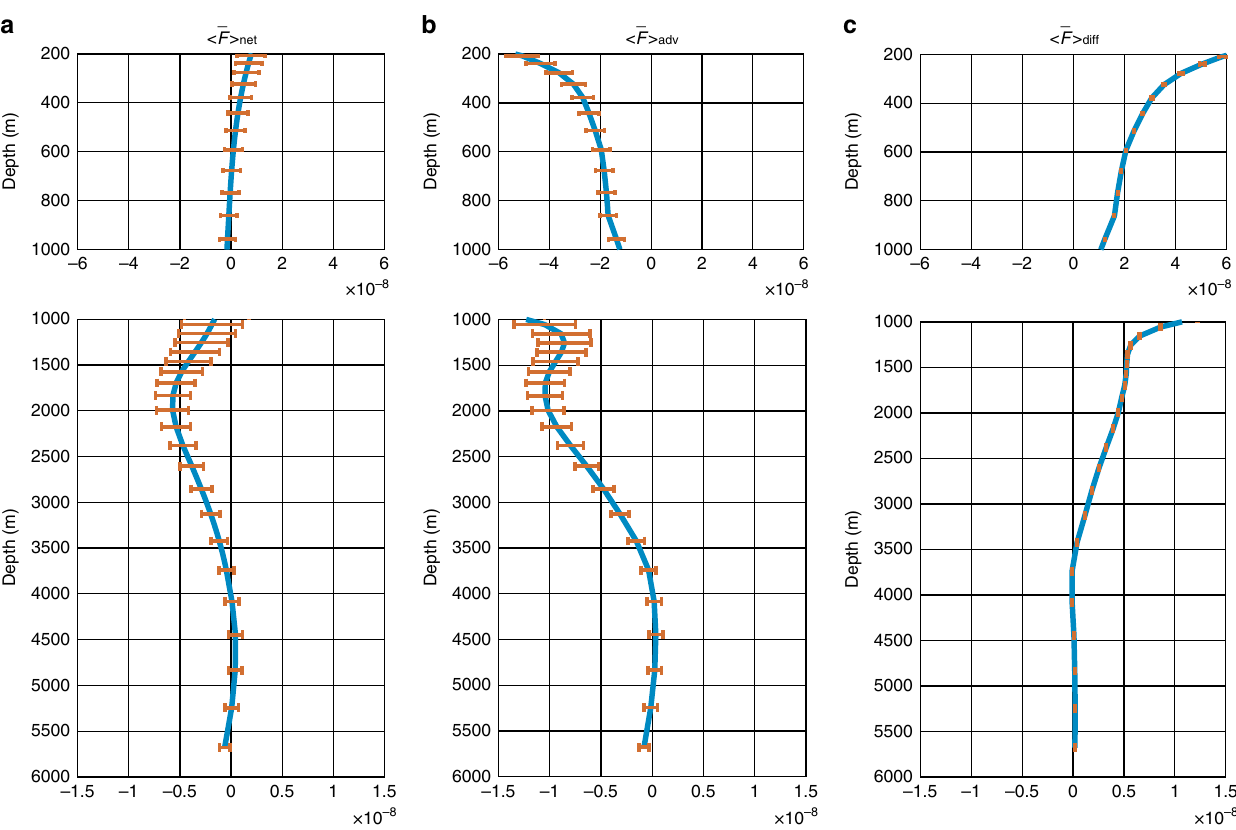
Fig. 4 22-year means of the globally averaged vertical salt fl uxes. a Temporal means of the horizontally averaged net vertical salt fl ux from January 1993 to December 2014 ( < (cid:1) F > , unit: psu m s − 1 ). b , c same as in ( a ) but for the advective ( < (cid:1) F > , b ) and diffusive ( < (cid:1) F > , c ) vertical salt fl uxes. Note that F net is net adv diff the sum of F adv and F diff . In all panels, positive values stand for upward salt fl ux. The upper 200 m are excluded to avoid direct impacts from the intense ffiffiffi p n high-frequency variability. The error bars are calculated as σ = , where σ is the temporal standard deviation of the corresponding fl ux term, and n is the degrees of freedom (261 in this